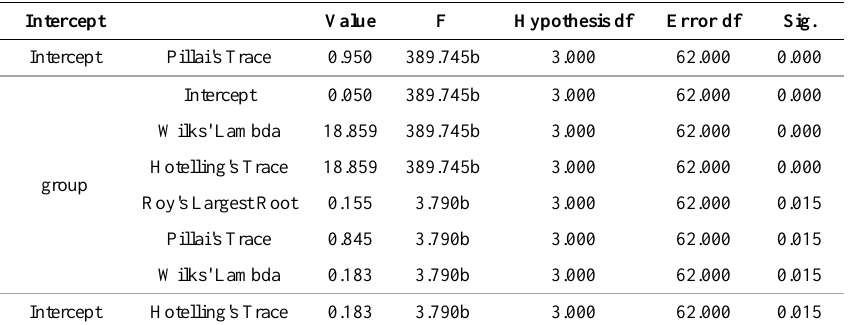
Table 6. Mean values from Multivariate